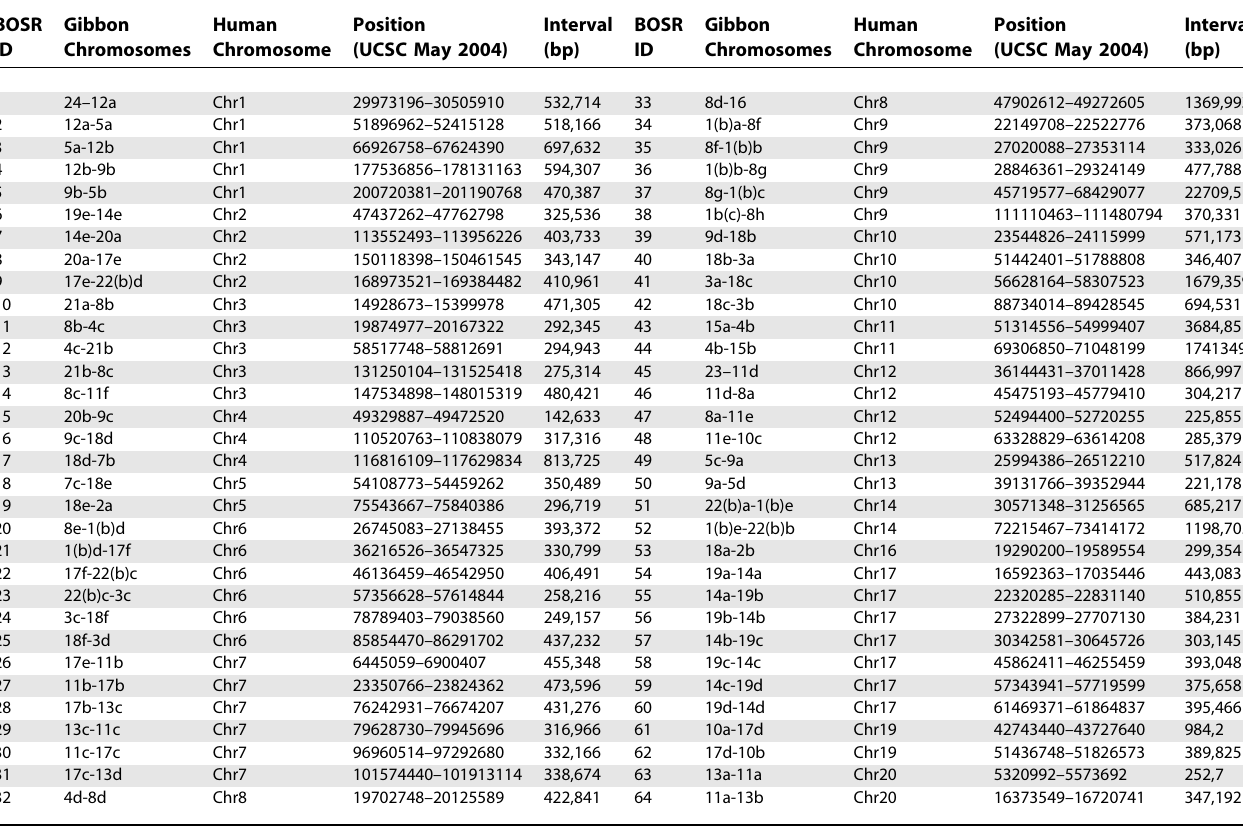
Table 1. Array-Painting Results BOSR Gibbon ID Chromosomes